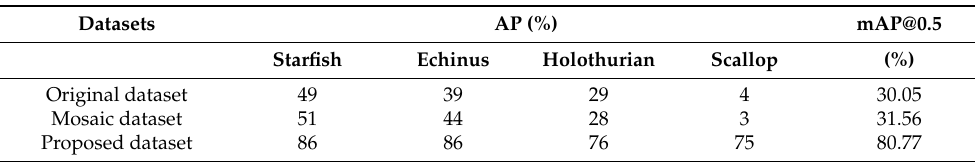
Table 1. Comparison of the different datasets.